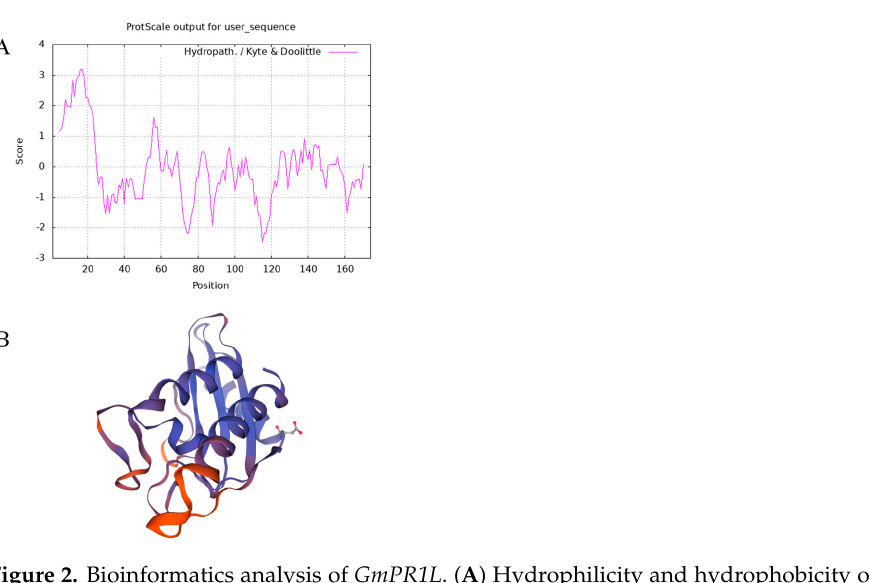
Figure 2. Bioinformatics analysis of GmPR1L . ( A ) Hydrophilicity and hydrophobicity of GmPR1L protein; ( B ) The tertiary structure of GmPR1L protein . 2.2. Acquisition of the GmPR1L Expression Vector and Production of Transgenic Soybean Plants The gene overexpression vector pCAMBIA3301- GmPR1L -over and the gene silencing vector pCAMBIA3301- GmPR1L -RNAi were successfully constructed through restriction enzyme digestion of Bgl Ⅱ and BstE Ⅱ . After PCR detection, the GmPR1L -overexpressing transgenic lines OEA1 and OEA2 and the GmPR1L -silenced lines IEA1 and IEA2 were obtained, which were added to T2 for subsequent functional identi fi cation. 2.3. Southern Blot Detection of Transgenic Soybean Plants According to the results of southern hybridization, the four transgenic plants showed hybrid fragments at di ff erent sites, with di ff erent sheet lengths, and in single copy forms (Figure 3), indicating that the exogenous screening marker Bar was successfully integrated into the plant genome.